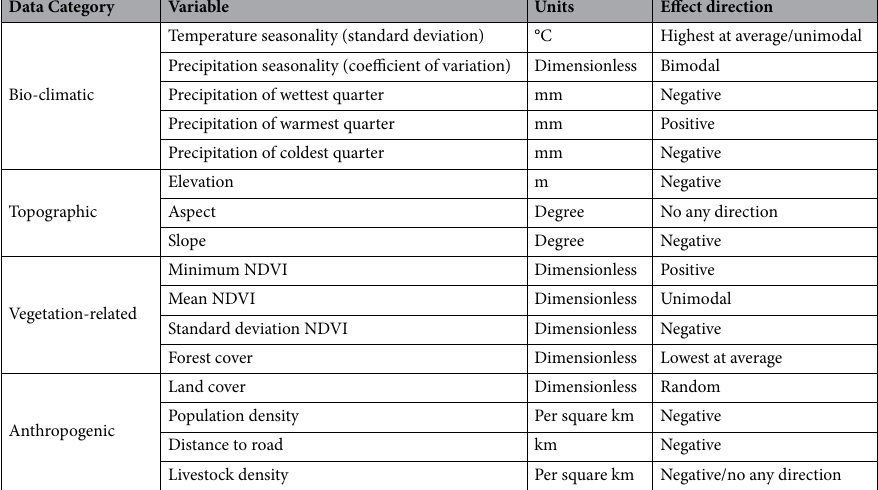
Table 1. Summary of the variables used within each data category of the analyses and the general direction of their effect on the probability of occupancy of an area by Egyptian vultures (i.e. positive = positive correlation with probability of occupancy) and the estimated magnitude of this